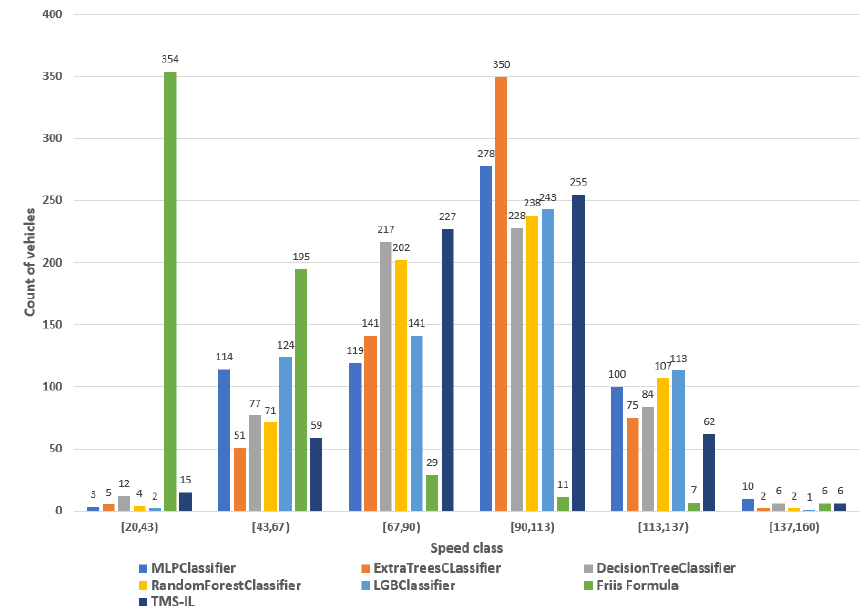
Figure 7. The 6-classes vehicle count per class over TMS-IL count per class. Table 6. The 6-classes—Classifiers ranking. Total APC per class and Friis equation total APC